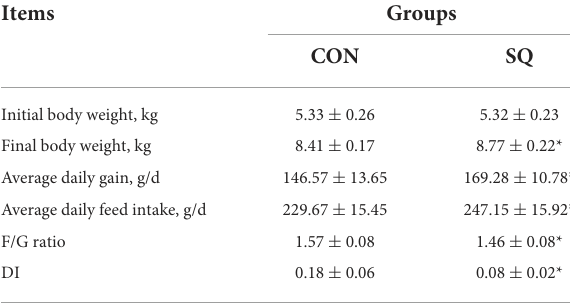
TABLE 1 The effects of squalene on the growth performance of weaned piglets. Items